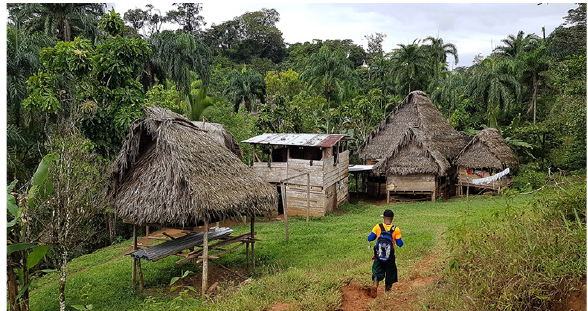
Figure 15. Comunidad de Los Santos, Ngäbe territory.